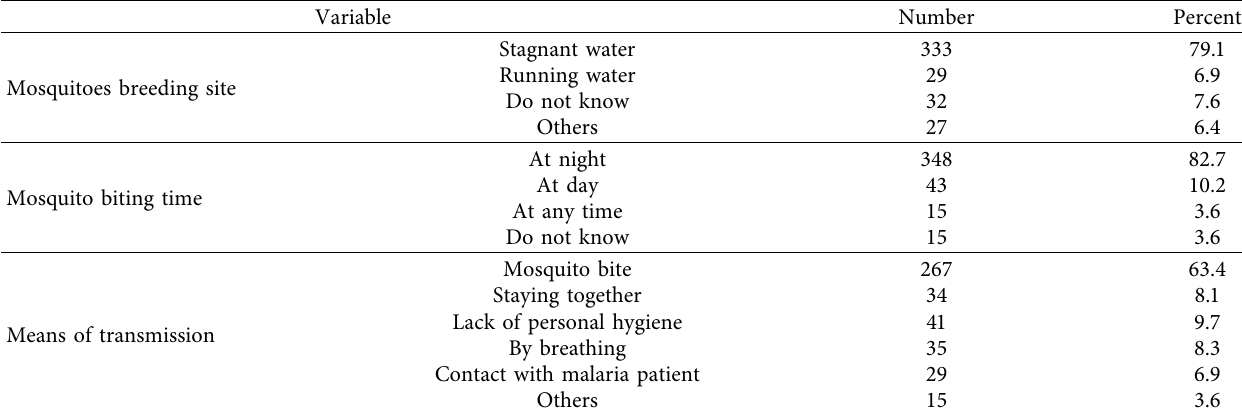
Table 2: Knowledge and attitude of respondents regarding mosquito breeding site, biting time, and transmission of malaria in Halaba town, Southern Ethiopia, September 2017.